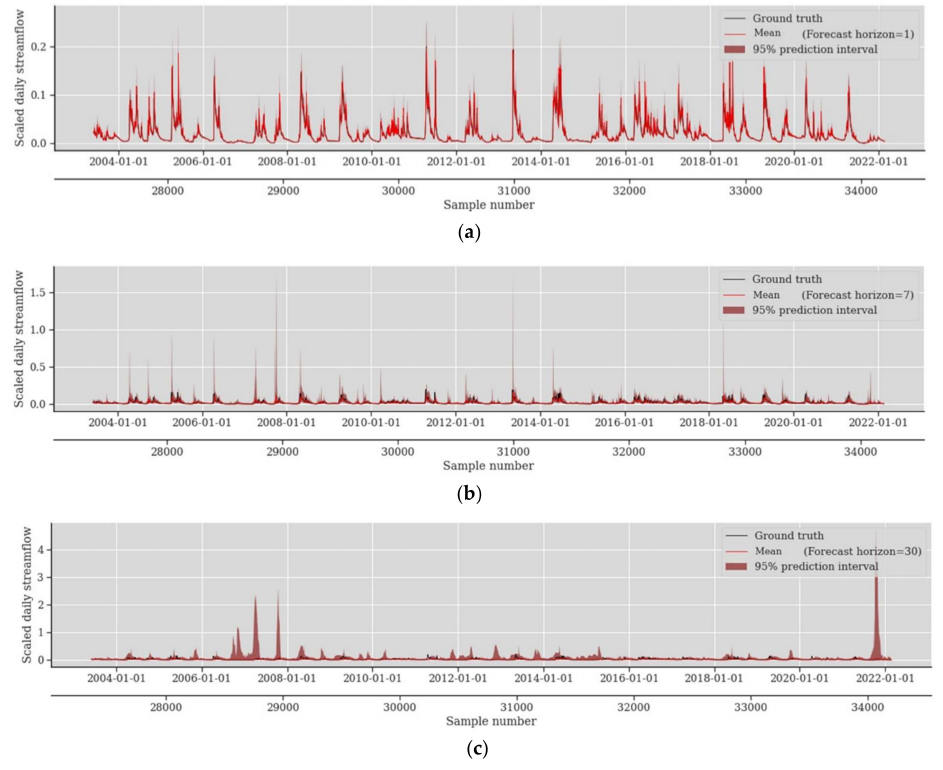
Figure 9. Probabilistic streamflow forecasting results obtained by BNN for case study II for ( a ) forecast horizon 1, ( b ) forecast horizon 7, and ( c ) forecast horizon 30.